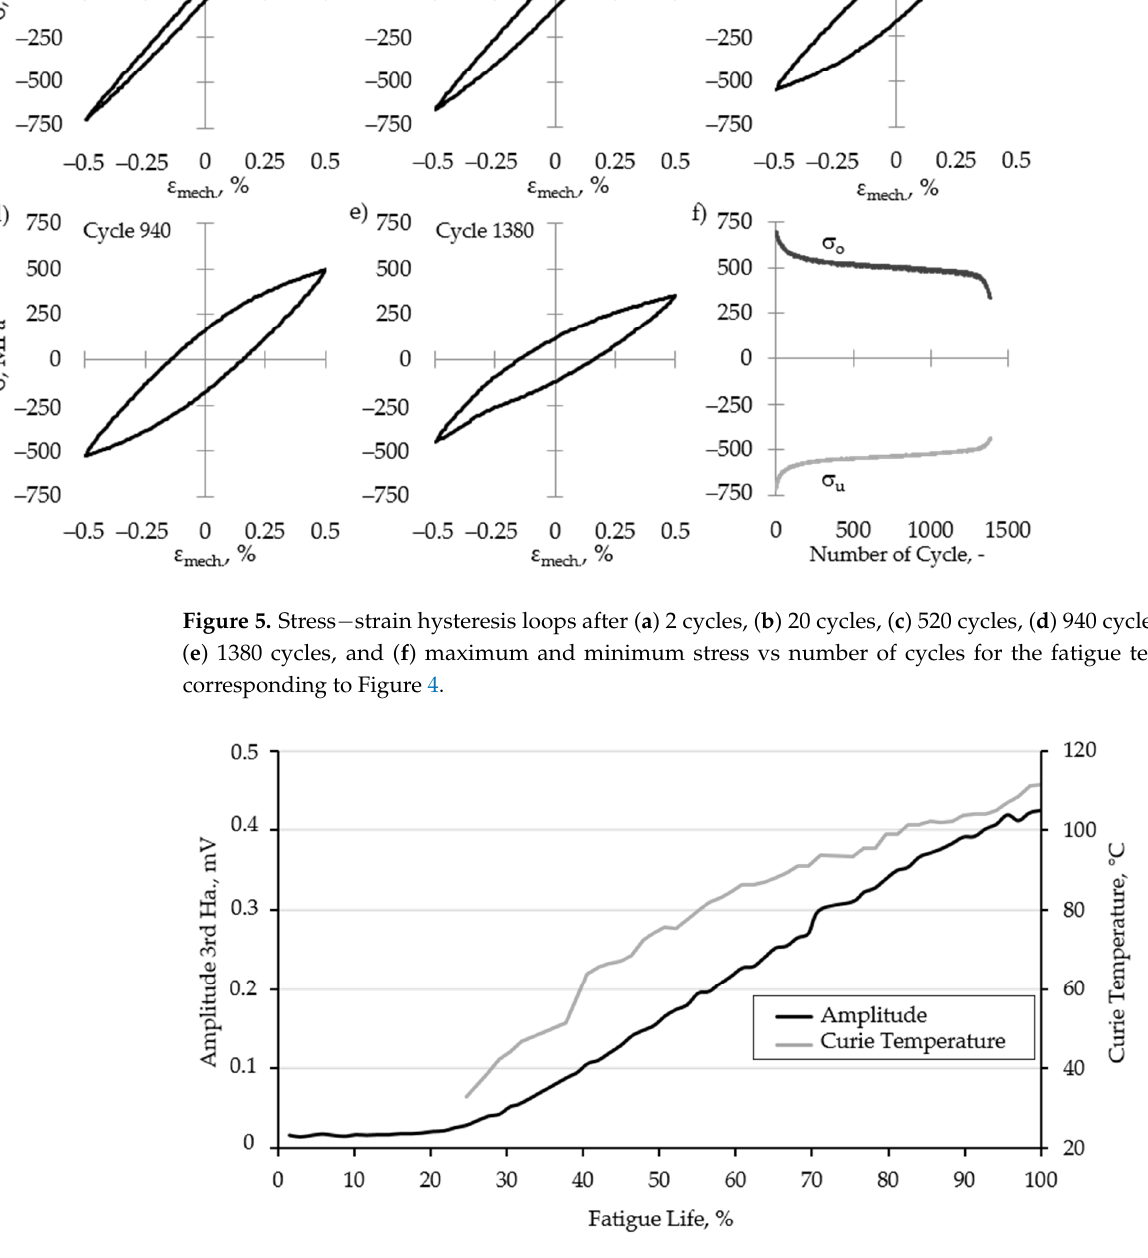
Figure 6. Amplitude of the third harmonic and Curie temperature versus fatigue life of the specimen subjected to 0.5% strain amplitude at 800 °C .